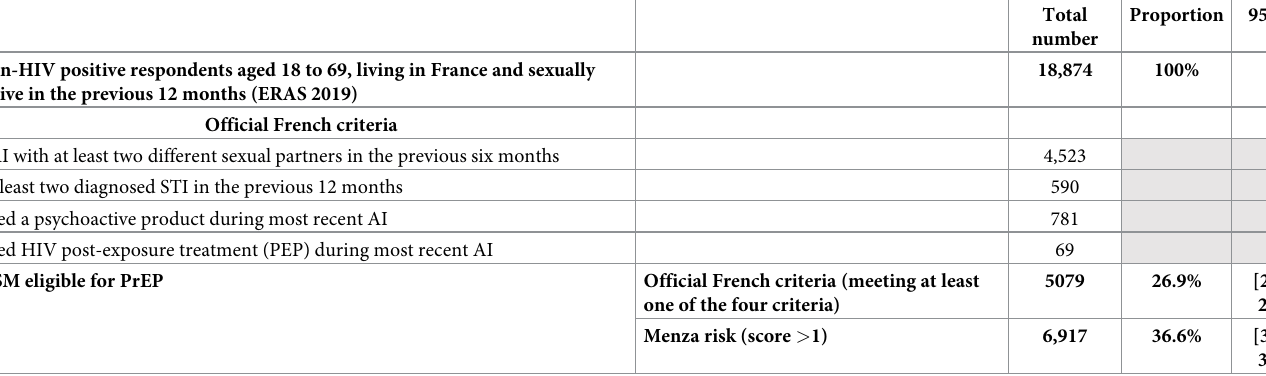
Table 3. Estimation of proportion of MSM eligible for PrEP in ERAS 2019